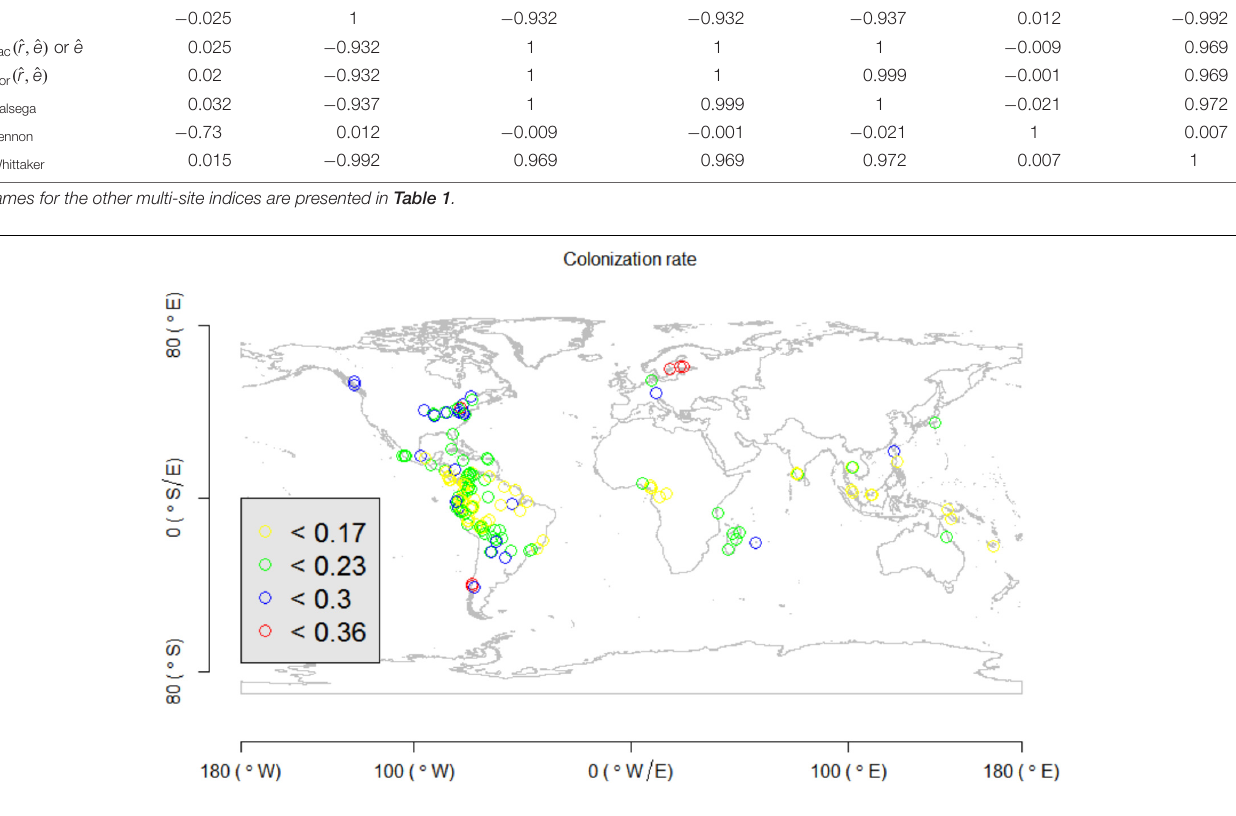
FIGURE 4 | Estimated colonization rate for global Gentry forest